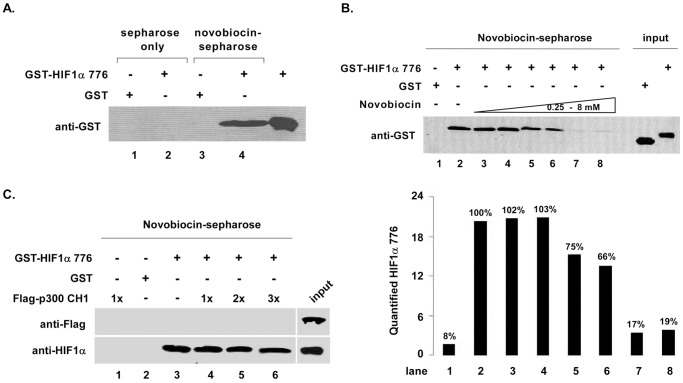
Novobiocin directly binds to HIF1α CTAD.
A. Novobiocin-sepharose pulled down HIF1α CTAD. Immobilized novobiocin-sepharose was prepared as described under §Experimental Procedures. GST fusion HIF1α CTAD (∼5 µg) was mixed with novobiocin-sepharose or novobiocin-free sepharose in a buffer containing 40 mM Tris-HCl (pH 7.4), 1% NP-40, 2 mM EDTA, 100 mM NaCl, and 1 mM sodium orthovanadate, and a protease inhibitor cocktail (Sigma). Protein mixtures were incubated at 4°C for 2 hours, and the beads were washed with ice-cold buffer. Bound proteins were eluted by boiling in 4×SDS loading buffer and were separated by SDS-PAGE, followed by Western blotting with anti-GST antibody. B. Novobiocin specifically binds to HIF1α CTAD. Protein mixtures of GST-HIF1α CTAD, novobiocin-sepharose and free novobiocin from 0.25 to 8 mM were incubated at 4°C for 2 hours, and the beads were washed with the same ice-cold buffer. Bound proteins were confirmed by Western blotting with anti-GST antibody (upper panel). Quantified proteins are shown in the bar graph (lower panel). Percentages above each bar represents bound HIF1α 776 protein compared to lane 2. C. HIF1α CTAD and p300 CH1 cannot compete for binding to novobiocin. Pre-equiliblited novobiocin-sepharose (∼20 µl) was mixed with ∼5 µg GST-HIF1α CTAD and Flag-p300 CH1 (5, 10, and 15 µg) in combinations indicated in the figure. Bound proteins were detected by Western blotting with indicated antibodies.